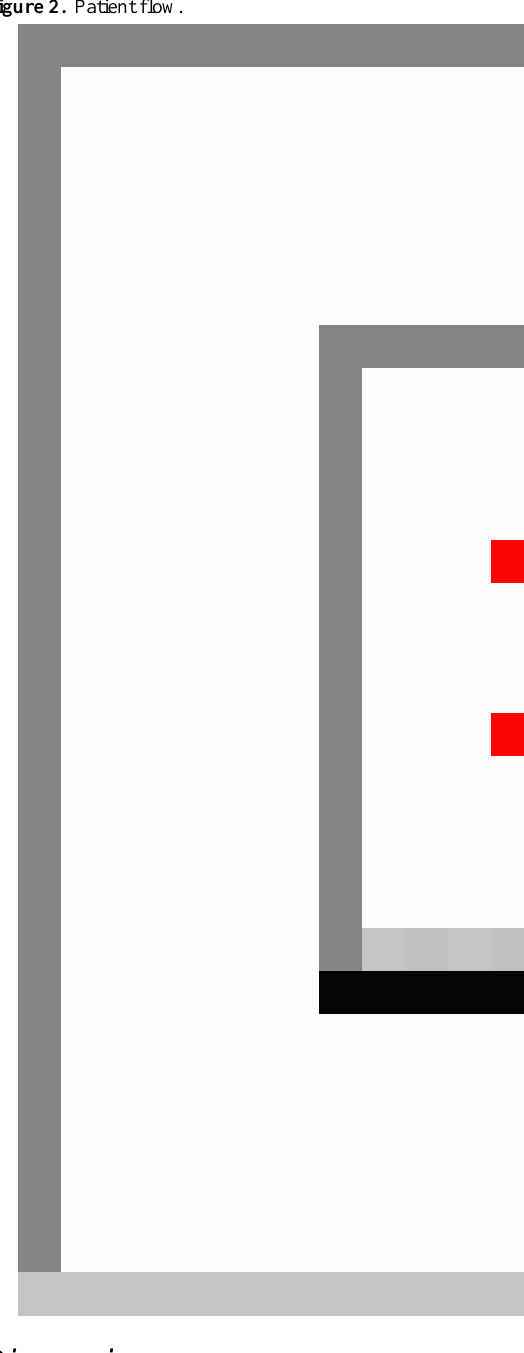
Figure 2. Patient